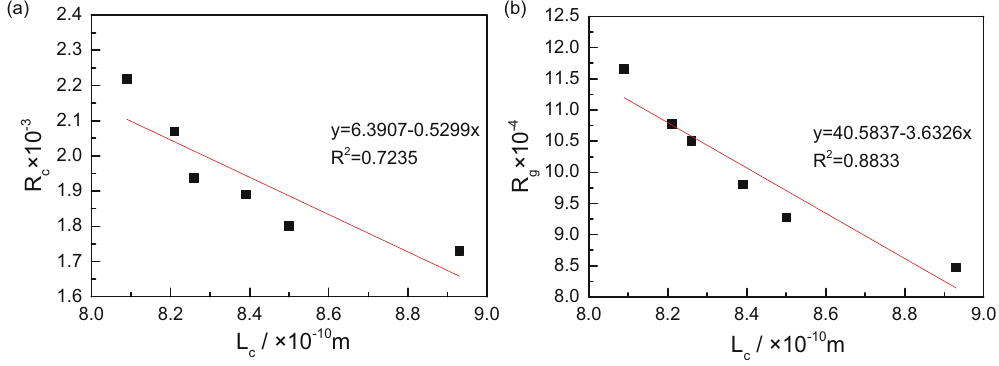
Figure 5: Relationships of semi - coke L c with combustion and gasi fi cation reactivity indexes. ( a ) L c vs R c ; ( b ) L c vs R g .